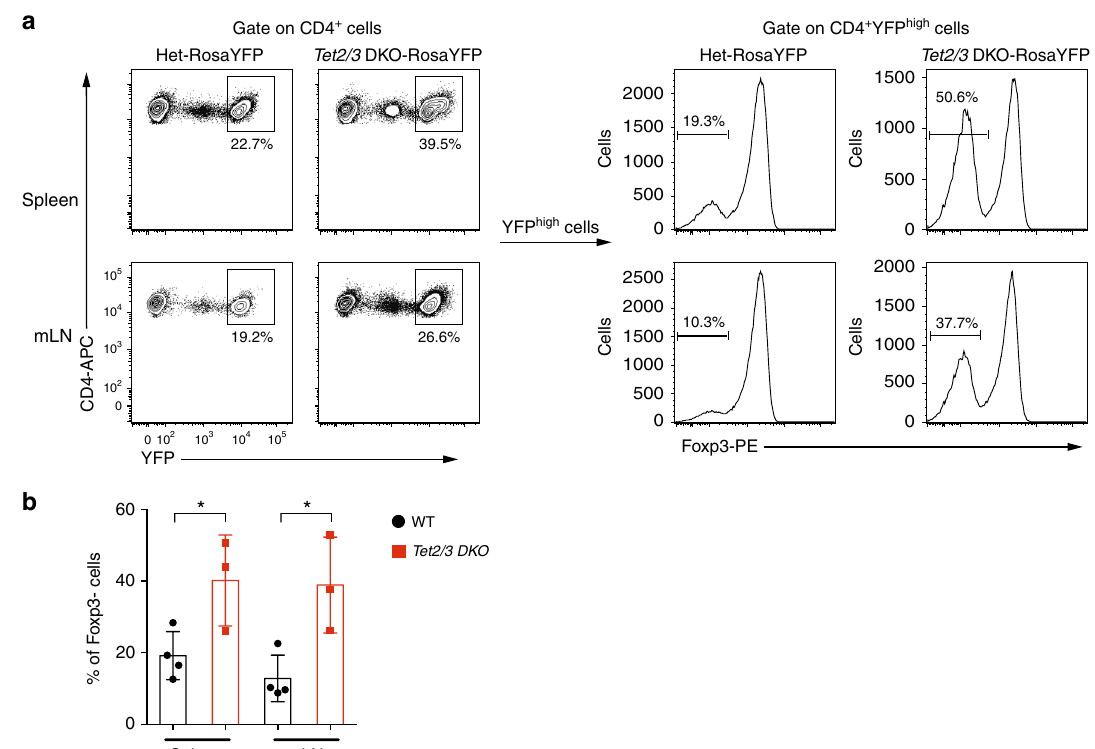
Fig. 6 Tet2/3 DKO Treg cells are less stable than Treg cells from heterozygous littermates. a Representative lineage tracing of Treg cells in spleen and mLN from littermate mice of Tet2 + / fl Tet3 fl / fl Foxp3 YFP-Cre Rosa26 YFP (Het) and Tet2/3 fl / fl Foxp3 YFP-Cre Rosa26 YFP genotypes. Left panels , Contour plots showing that Rosa26 YFP is much brighter than, and so can be distinguished from, Foxp3 YFP-Cre . Right panels , The percentage of Foxp3-negative cells is much higher in sorted CD4 + Rosa26 YFPhigh cells from Tet2/3 fl / fl Foxp3 YFP-Cre Rosa26 YFP ( Tet2/3 DKO ) mice compared to those from Tet2 + / fl Tet3 fl / fl Foxp3 YFP-Cre Rosa26 YFP mice, indicating that Tet2/3 DKO Treg cells that had originally turned on Foxp3 and Cre from the Foxp3 YFP-Cre locus later lose Foxp3 and become